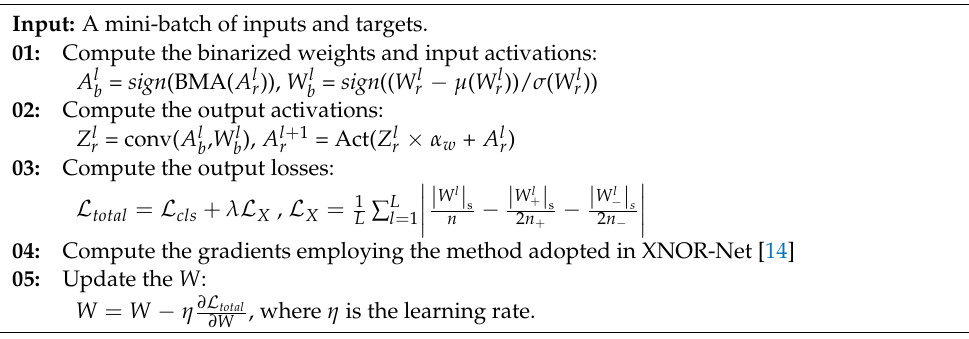
Algorithm 1. Training Flow of the BNNs using Our-proposed ML and BMA.